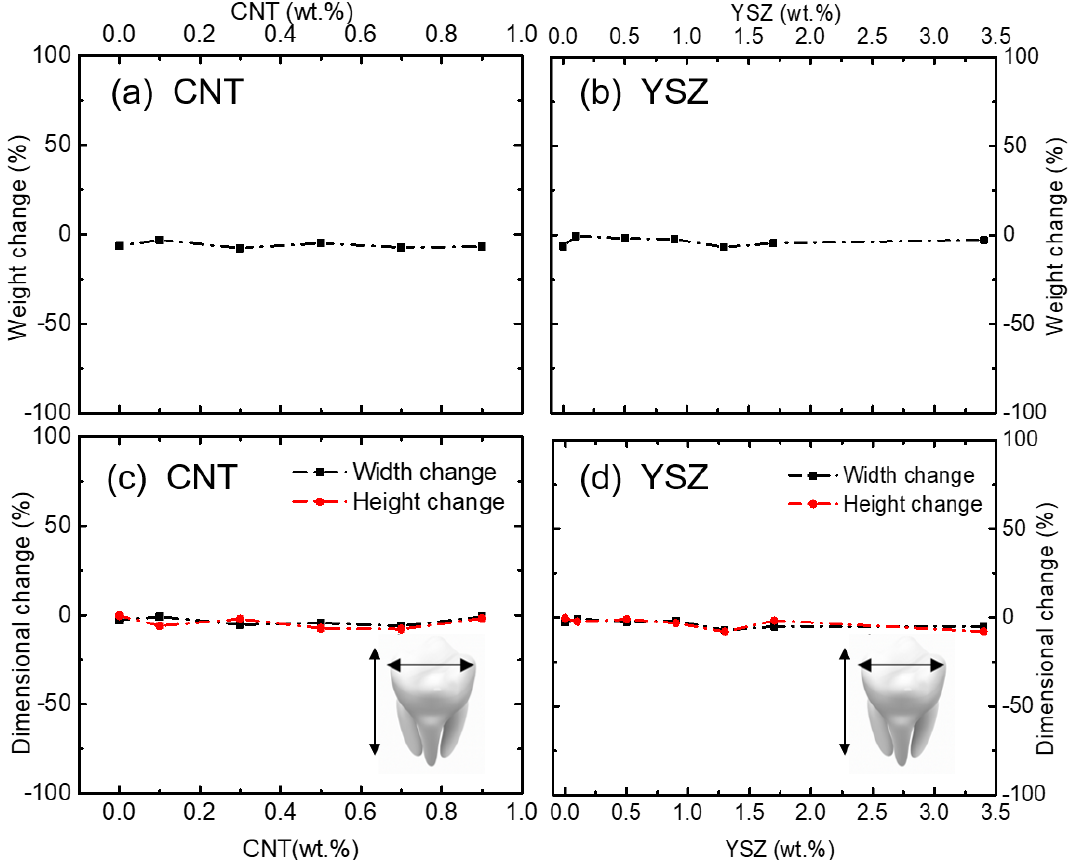
Figure 9. ( a , b ) Weight and ( c , d ) dimensional changes of 3D-printed teeth for CNT − and YSZ − added specimens, respectively, after 3 days of treatment with Listerine ® . No significant changes in weight and size were observed for both CNT − and YSZ − added specimens.